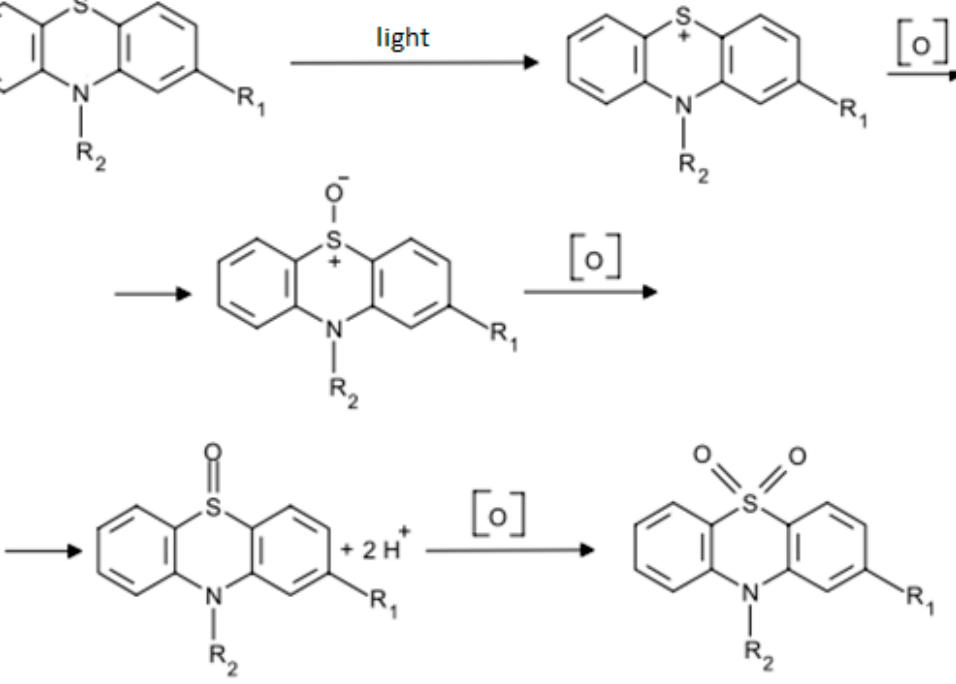
Figure 7. Preceding and subsequent chemical reactions of the interaction of the antioxidant with molecular oxygen.